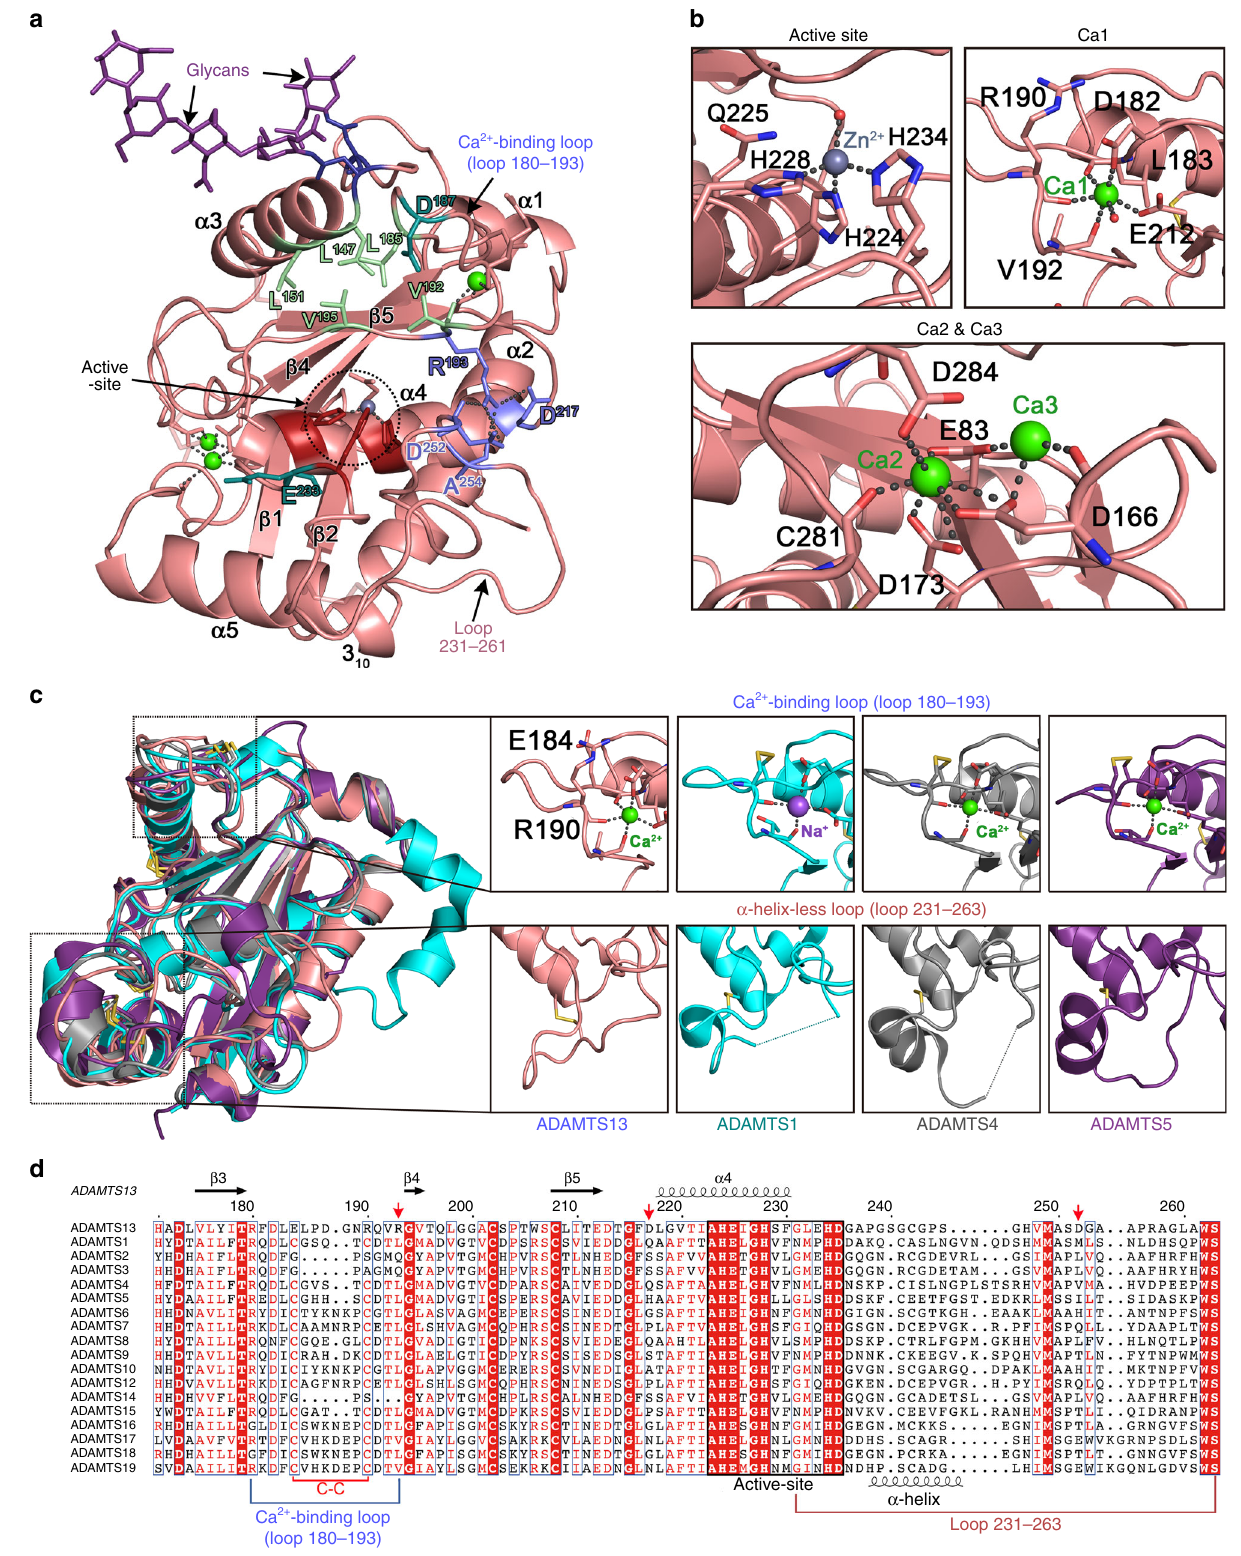
the Dis domain exosite (located at the end of the active-site cleft) and the active-site itself (Supplementary Movie 2). Arg 193 , Asp 217 , and Asp 252 are unique to ADAMTS13 (Fig. 7d), but are conserved across an amino acid sequence alignment of species from the human to zebra fi sh ADAMTS13.